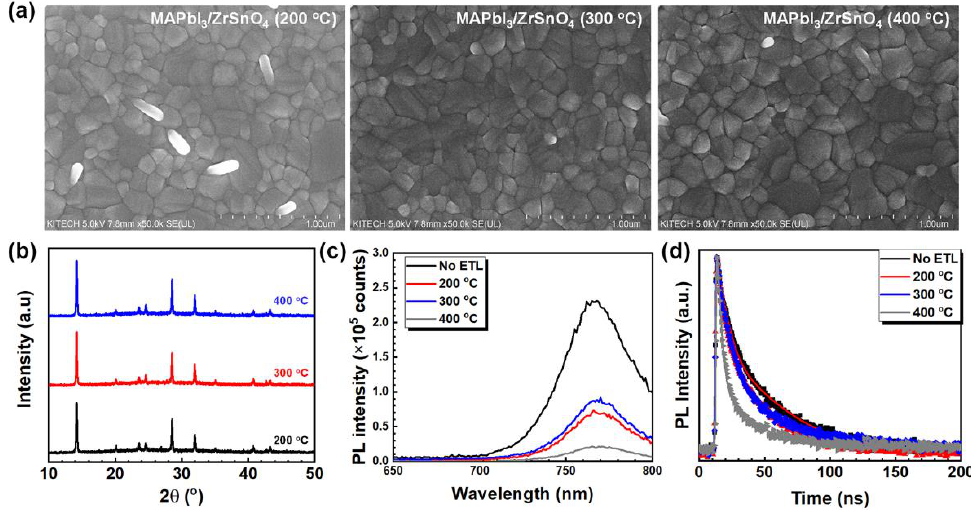
Figure 3. FE-SEM images of the top view ( a ), XRD diffractograms ( b ), PL spectra ( c ), and TRPL curves ( d ) of perovskite absorber layer deposited on the sol-gel-driven ZrSnO 4 films annealed at different temperatures. Based on the above investigation, the photovoltaic properties of the ZrSnO 4 ETL- based PSCs were examined. The planar-heterojunction devices were fabricated with an n - i - p structure (ITO/ZrSnO 4 ETL/CH 3 NH 3 PbI 3 /Spiro-OMeTAD/Au). The cross-sectional